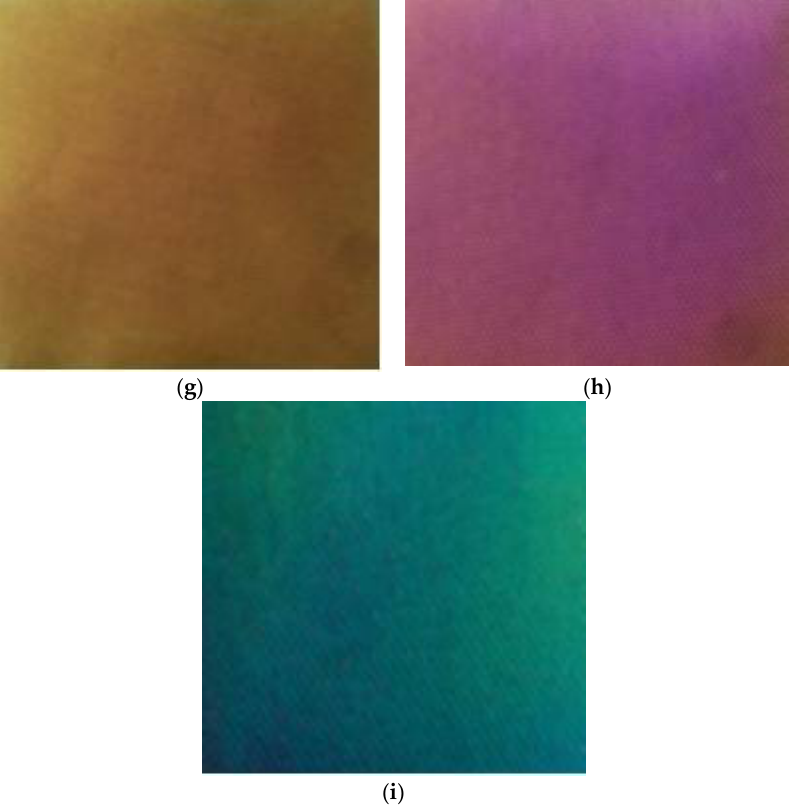
Figure 3. Color photographs of the original sample and the samples with different sputtering time of TiO 2 film: ( a ) Original sample; ( b ) 10 min; ( c ) 12 min; ( d ) 18 min; ( e ) 20 min; ( f ) 26 min; ( g ) 27 min; ( h ) 30 min; ( i ) 45 min.